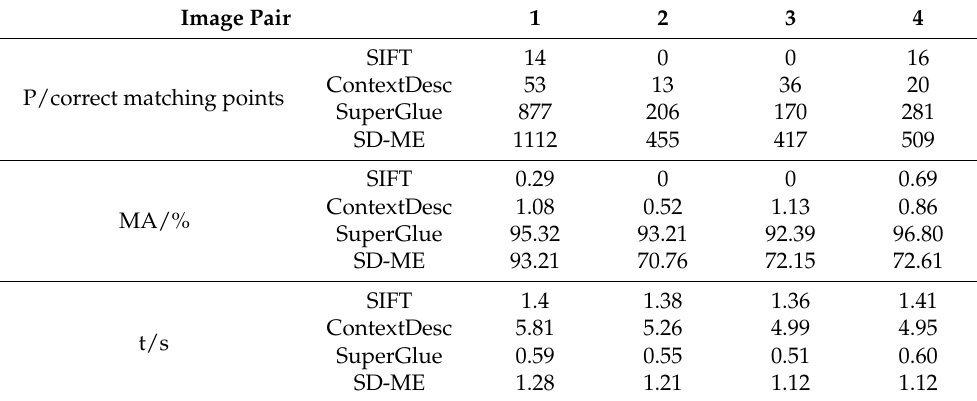
Table 1. Comparison of matching test